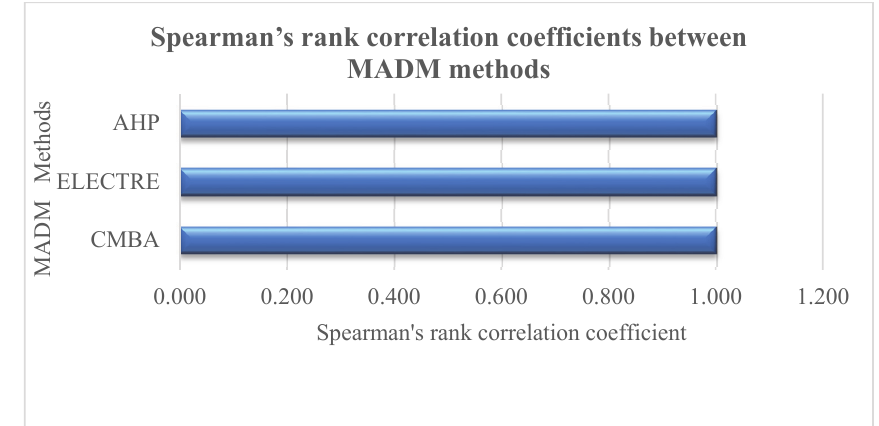
Fig. 6. Spearman's rank correlation coefficients between MADM